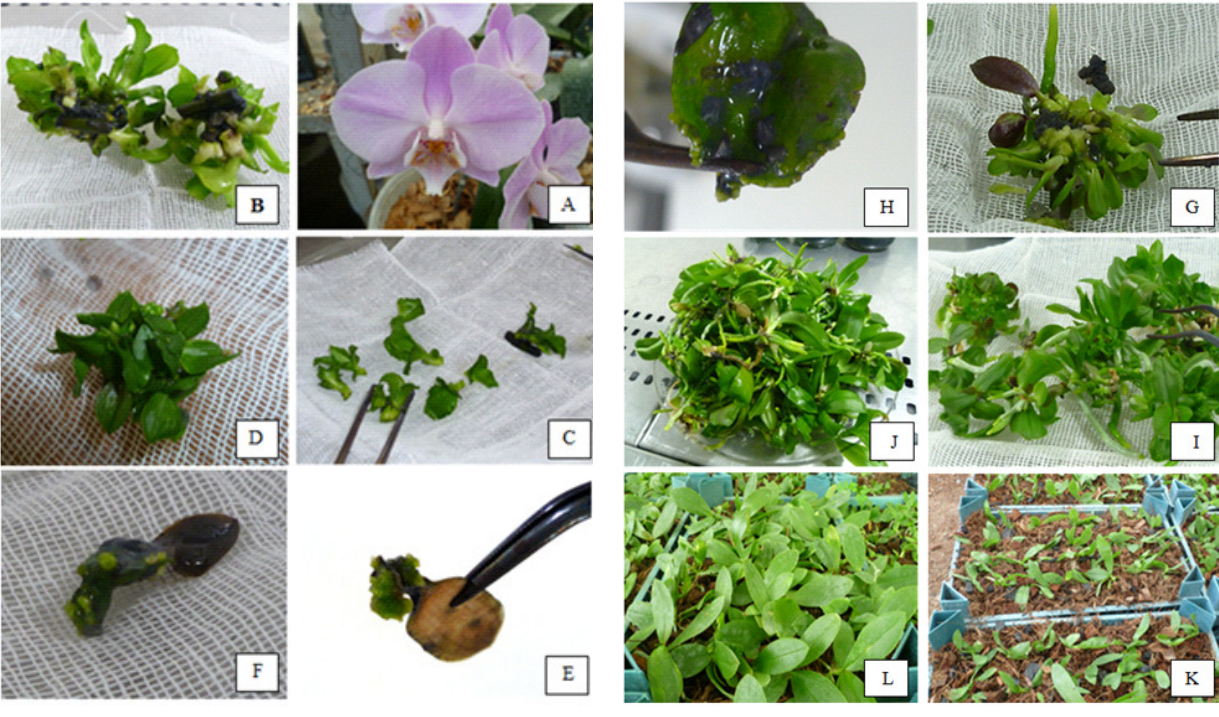
Fig. 2 (continued): G: protocorms produced in medium with 15 mg l -1 BAP and 3 mg l -1 NAA. H: protocorms produced in medium with 6 mg l -1 BAP and 1 mg l -1 NAA. I: separating the explants from each other and moving them to half-strength MS medium containing 2 g -l activated charcoal, with no growth regulators. J: removing the plantlets from jars of the tissue culture and preparation for acclimation. K: plantlets moved to medium of cocopeat + coal (volume ratio 3:1) for acclimation to greenhouse conditions. L: healthy plantlets after 2 months following the acclimation, positioned in cocopeat + coal (volume ratio